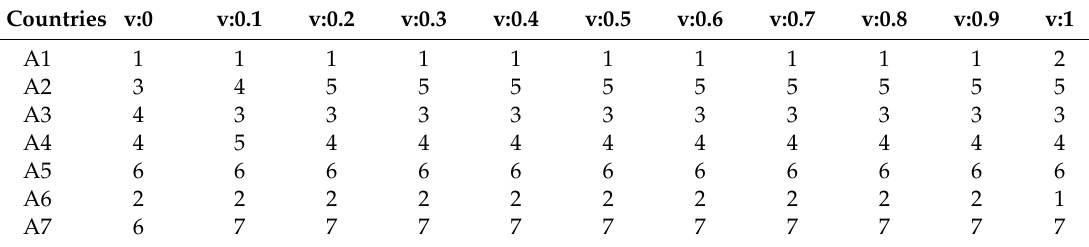
Table 11. Ranking of countries for di ff erent strategies of maximum group utility. Countries